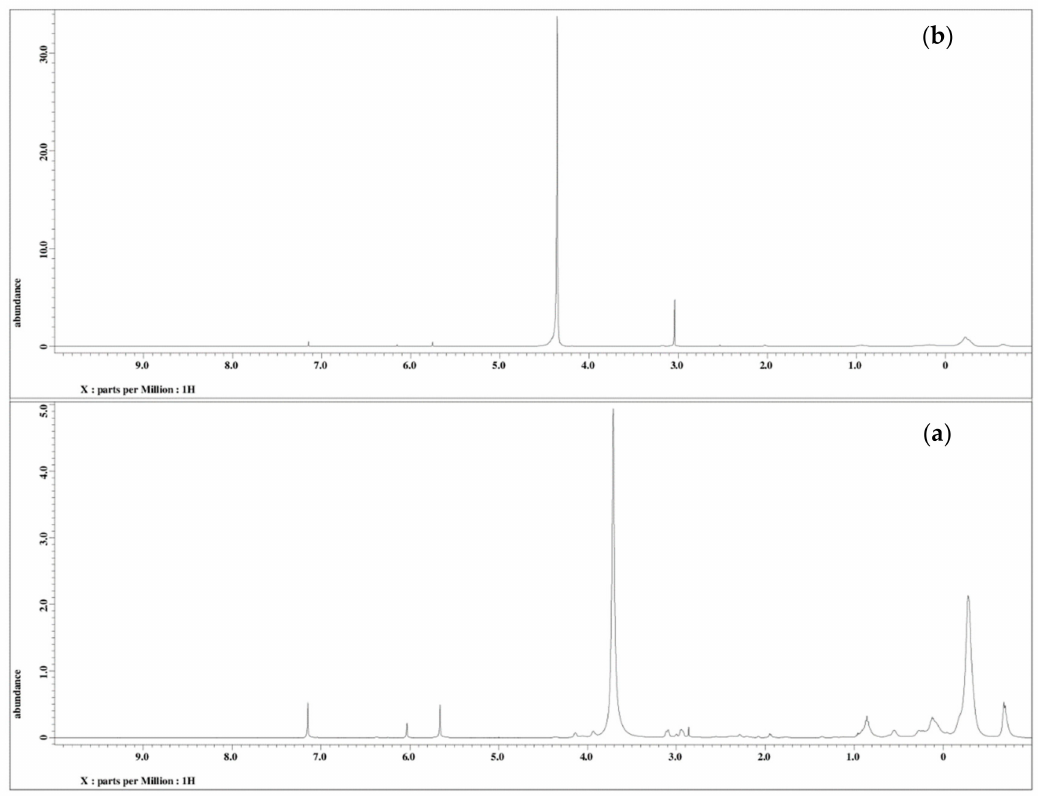
Figure 8. 1 H NMR spectra ( a ) PU and ( b ) PU-25LiClO 4